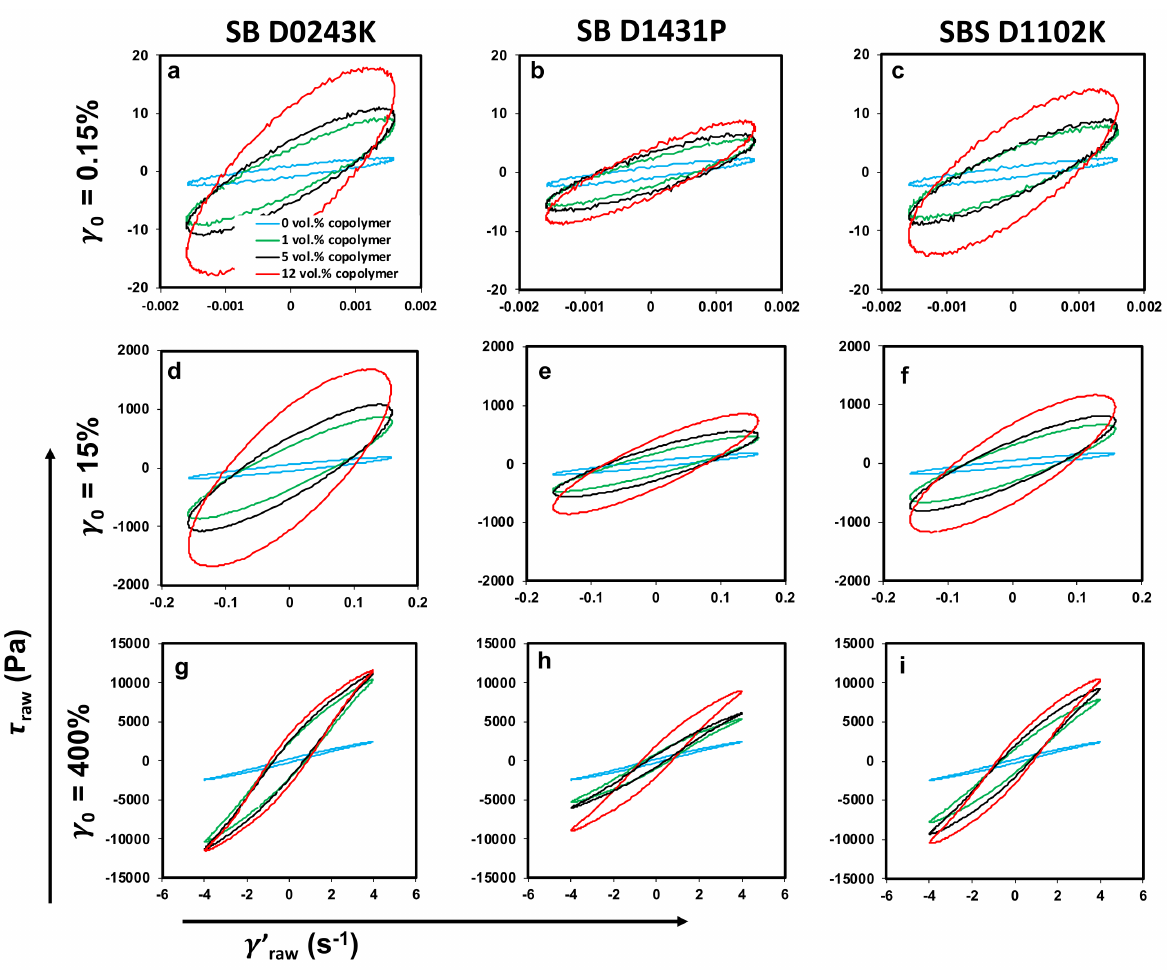
Figure 13. ( a – i ) Viscous Lissajous–Bowditch loops for PP:PS/70:30/MWCNT 1 vol.% and PP:PS/70:30/MWCNT 1 vol.%/copolymers. Projections on the viscous ( τ − d γ ) plane are presented at strain amplitudes of γ 0 = 0.15%, 15%, and dt 400% and an angular frequency of ω = 1 rad/s at 200 ◦